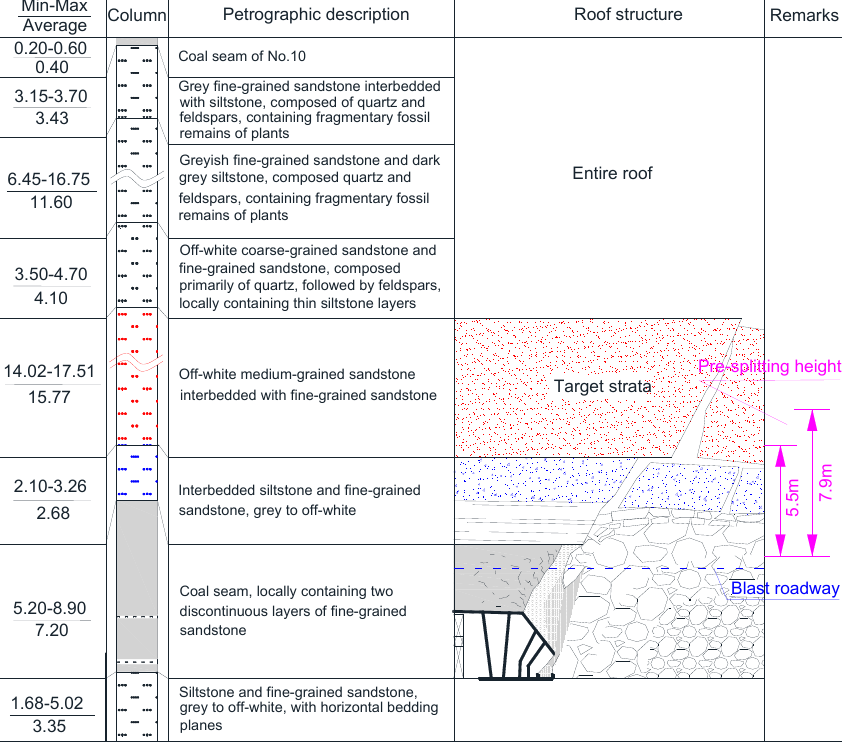
Anchor cable: 17.8 mm in diameter and 5300 mm long, the segment buried in rock > 2 m; cable tray size: